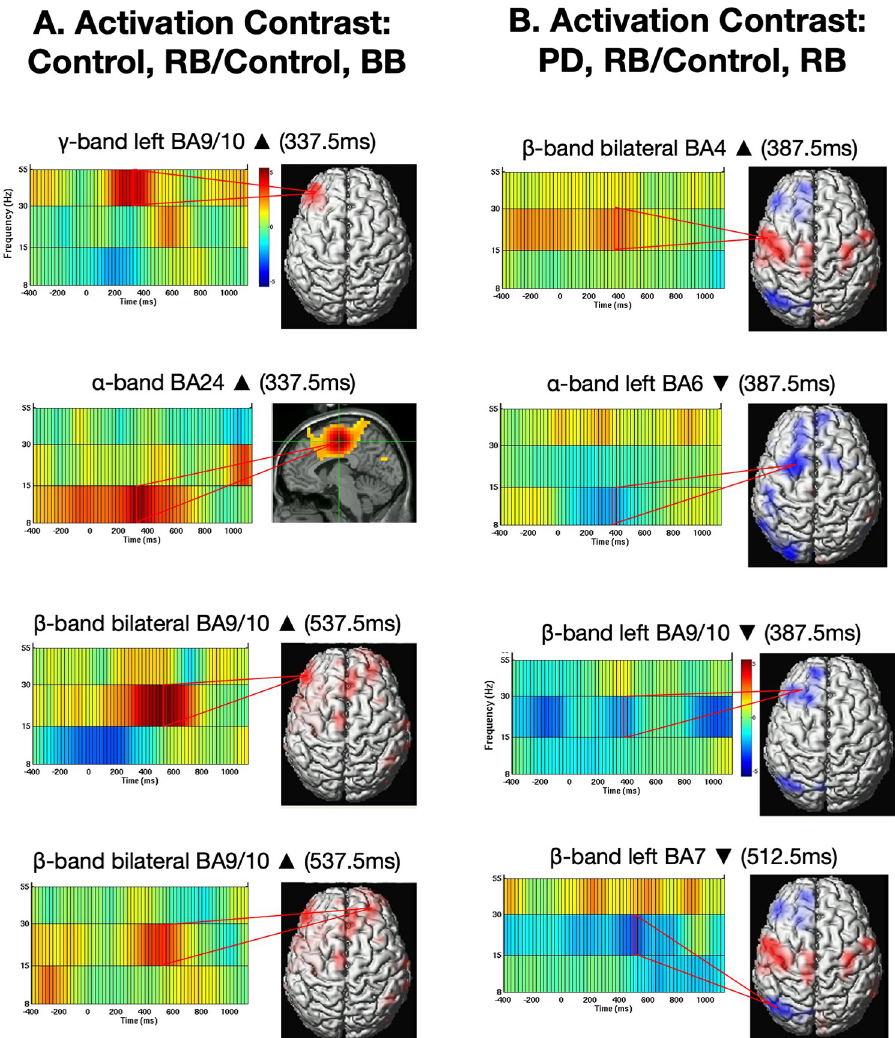
Fig 2. Activation contrast analysis. (A) Differences in peak intensity in the control group for mismatched activation trials versus matched control trials. (B) Differences in peak intensity during mismatched activation trials between the PD and control groups. MS = millisecond. Scale color bar represents power in arbitrary units. Peak activity indicates a significant change at p < 0.05, corrected for multiple comparisons except for the gamma band. To identify gamma band activity, we used a more liberal threshold (significant at p < 0.05, uncorrected). R = right hand, B = bilateral.